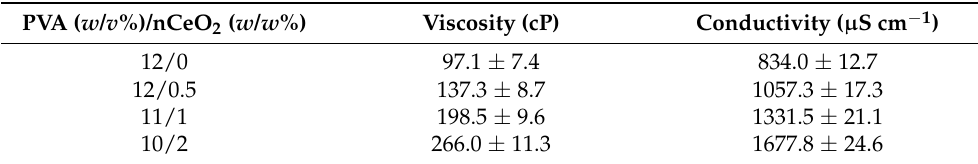
Table 2. Viscosity and conductivity of PVA/nCeO 2 blends.